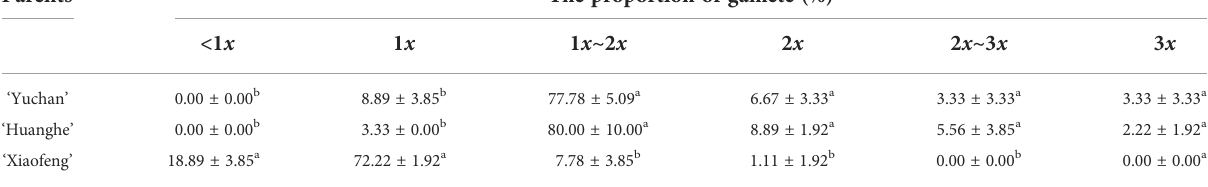
TABLE 3 Type and proportion (%) of male gametes in diploid and sexual triploid cymbidiums. Parents The proportion of gamete (%)